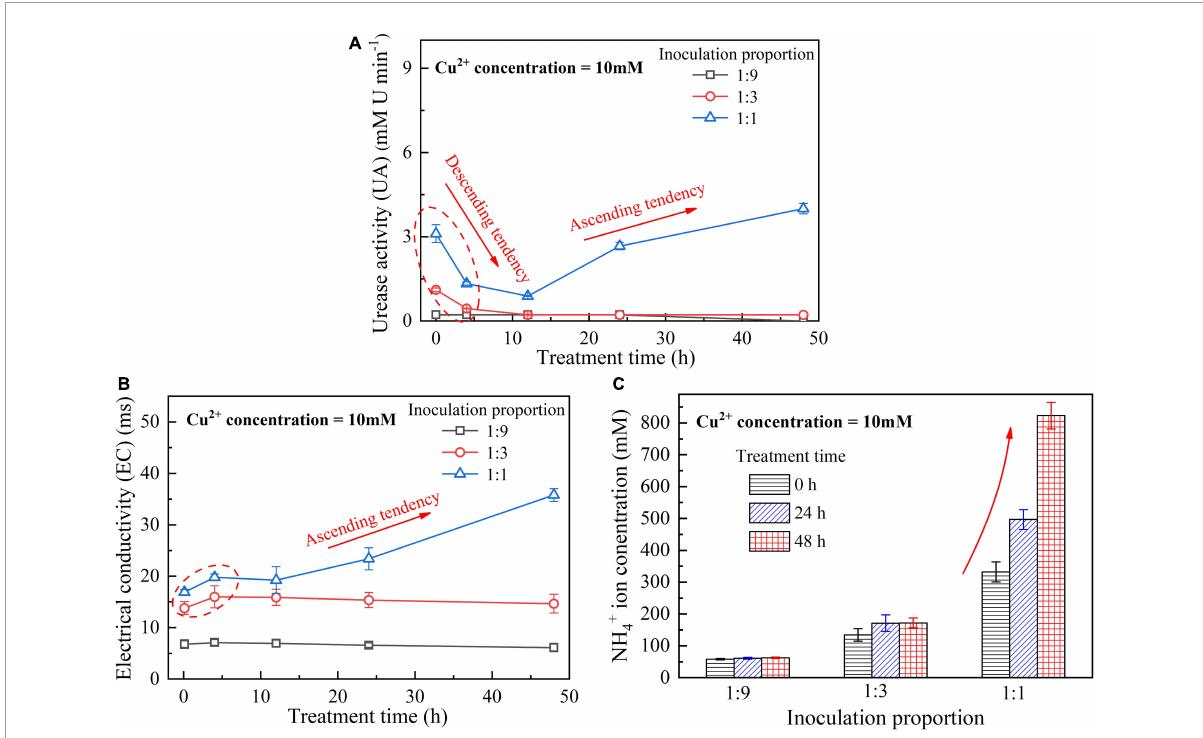
FIGURE2 (A) UA vs. treatment time relationship, (B) EC vs. treatment time relationship, and (C) NH 4 + vs. treatment time relationship when subjected to Cu 2 + concentration at 10 mM.